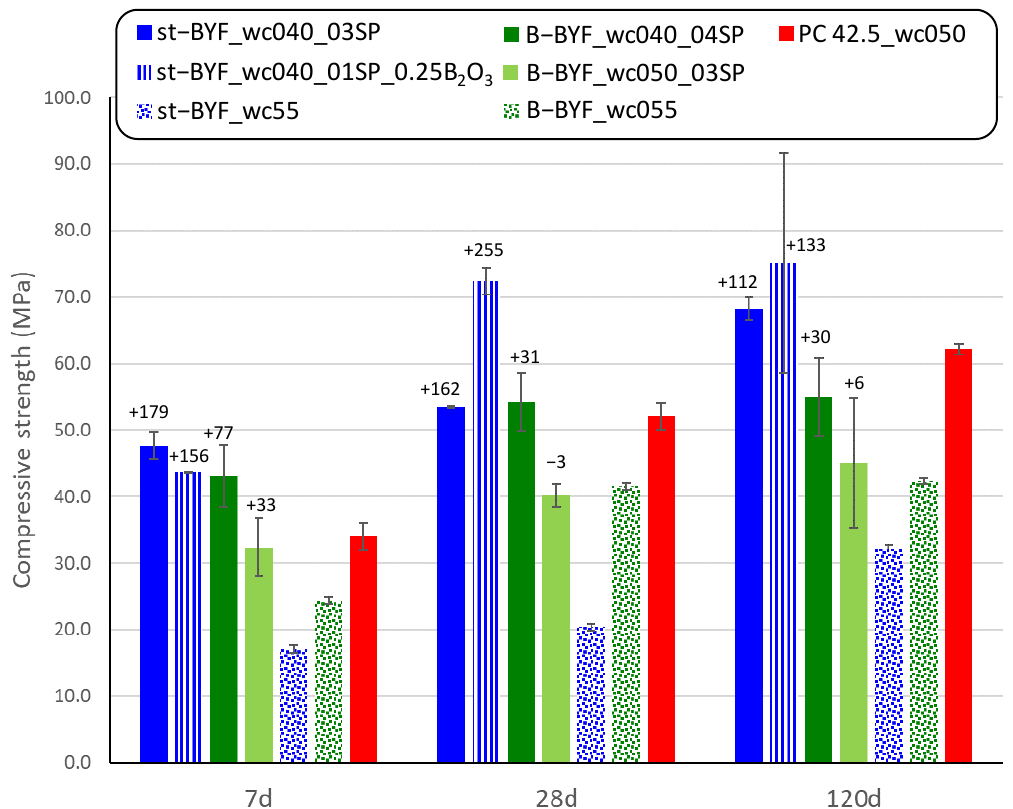
Figure 9. Compressive strengths of selected st-BYF and B-BYF mortars. Data from [22] and a type I 42.5R PC prepared as UNE-EN196-1 are also given for the sake of comparison. Percentage of mechanical strengths with respect to those with w/c of 0.55 from [22].